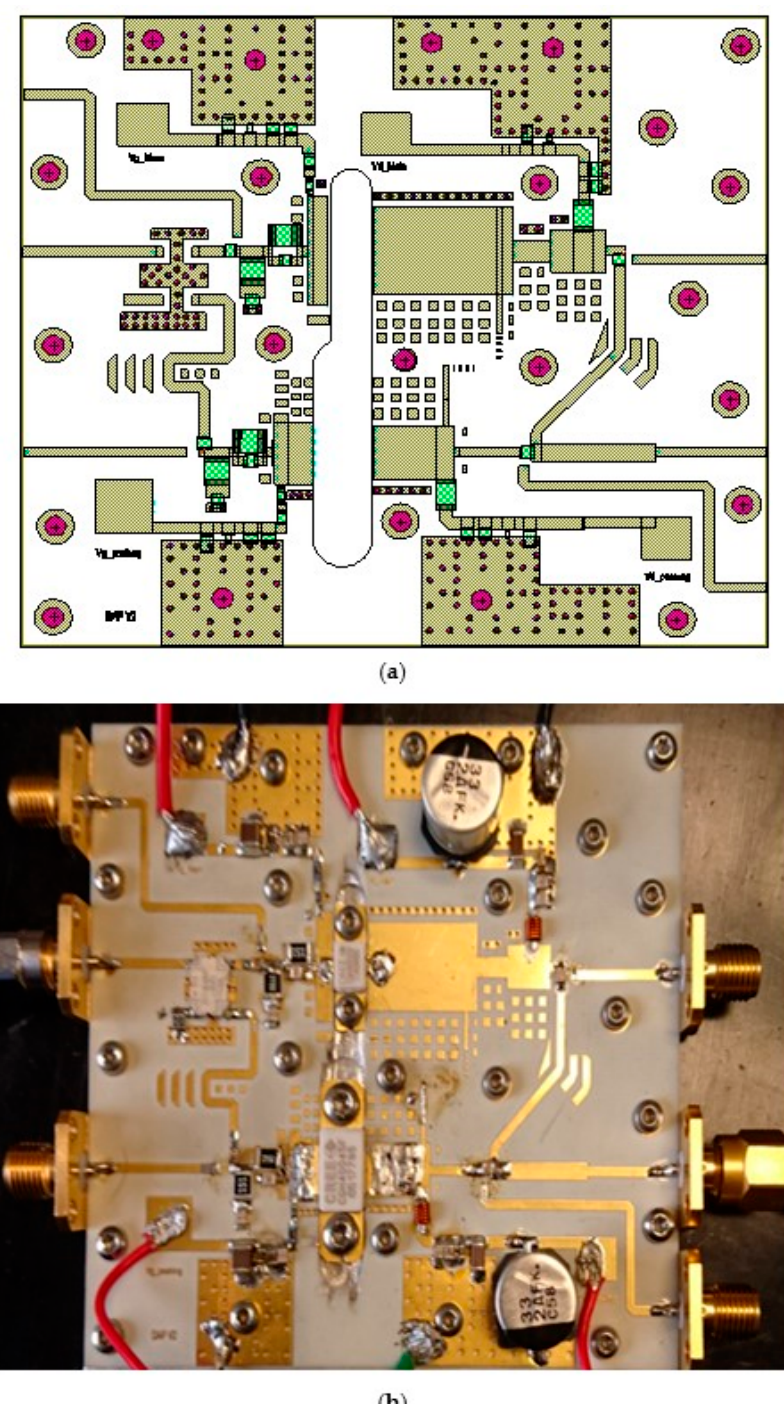
Figure 6. Designed amplifier; ( a ) Circuit layout and ( b ) fabricated circuit.